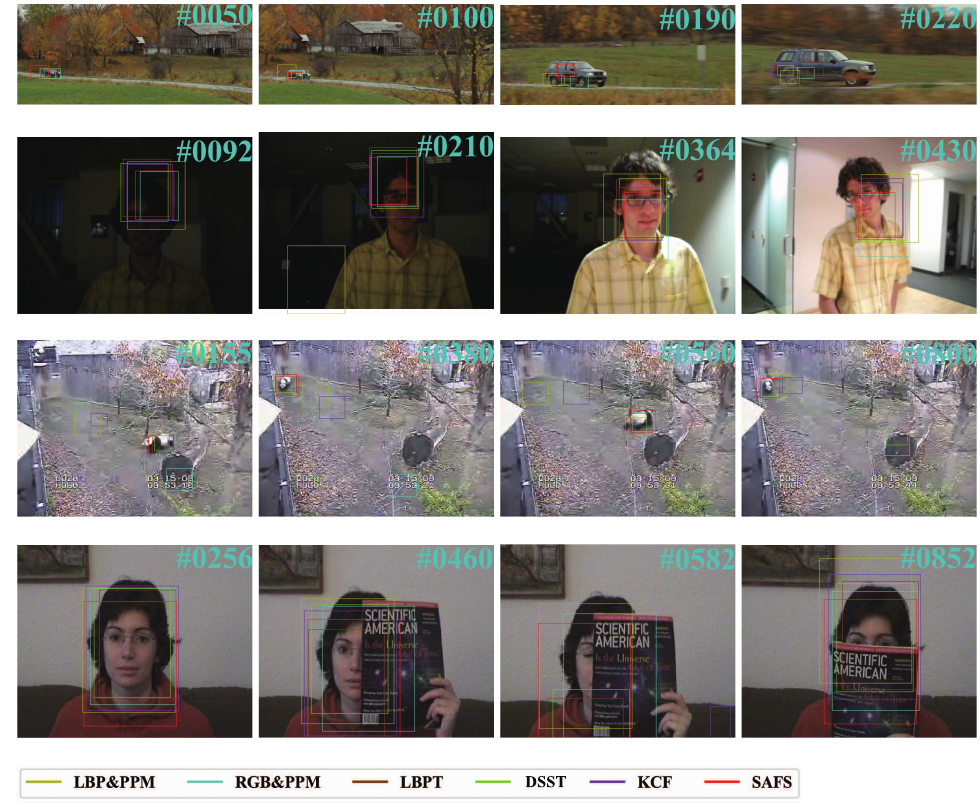
Figure 5. Experiment results of some fundamental frames of six algorithms on four sequences (CarScale, David, Panda, FaccOcc1).